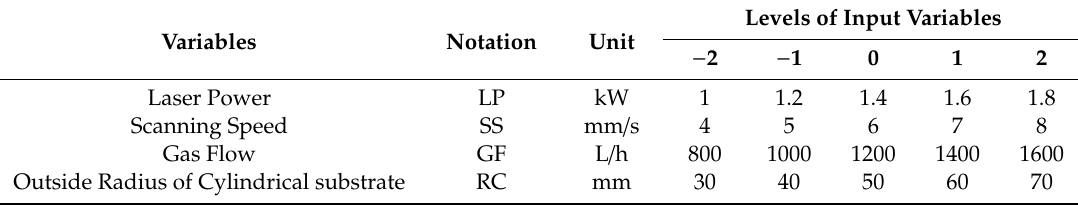
Table 2. Levels of laser cladding processing parameters and substrate size in the central composite design (CCD).